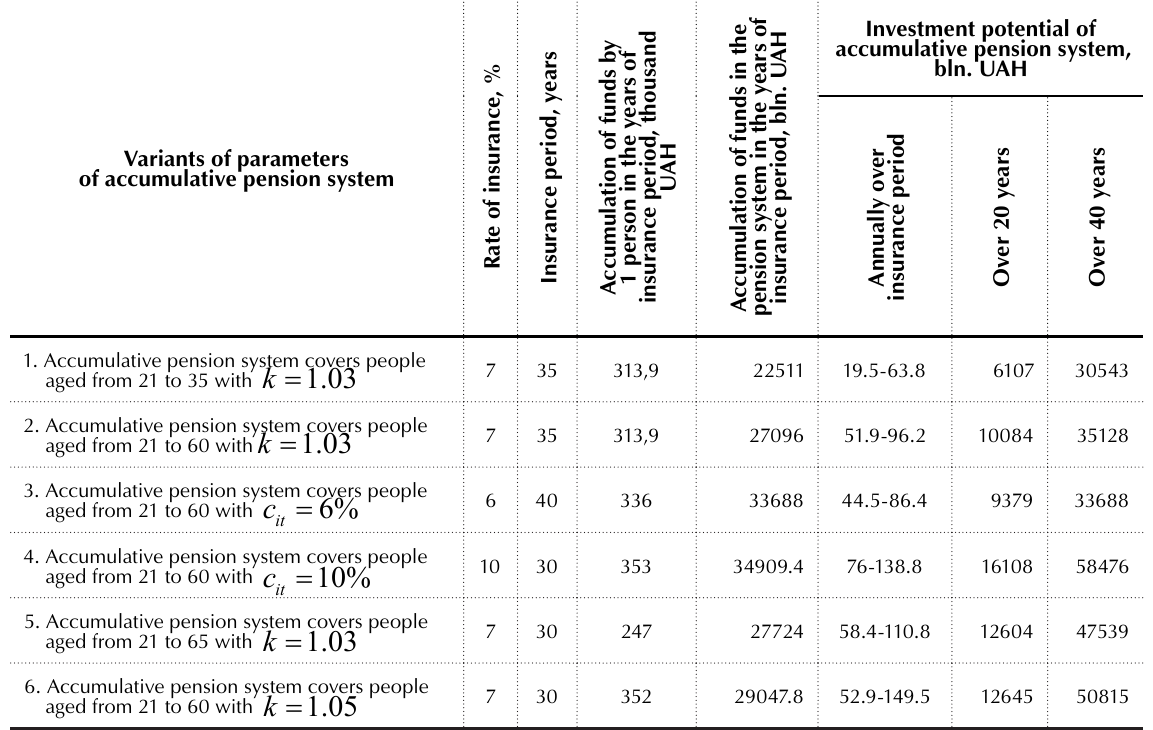
Variants of parameters of accumulative pension